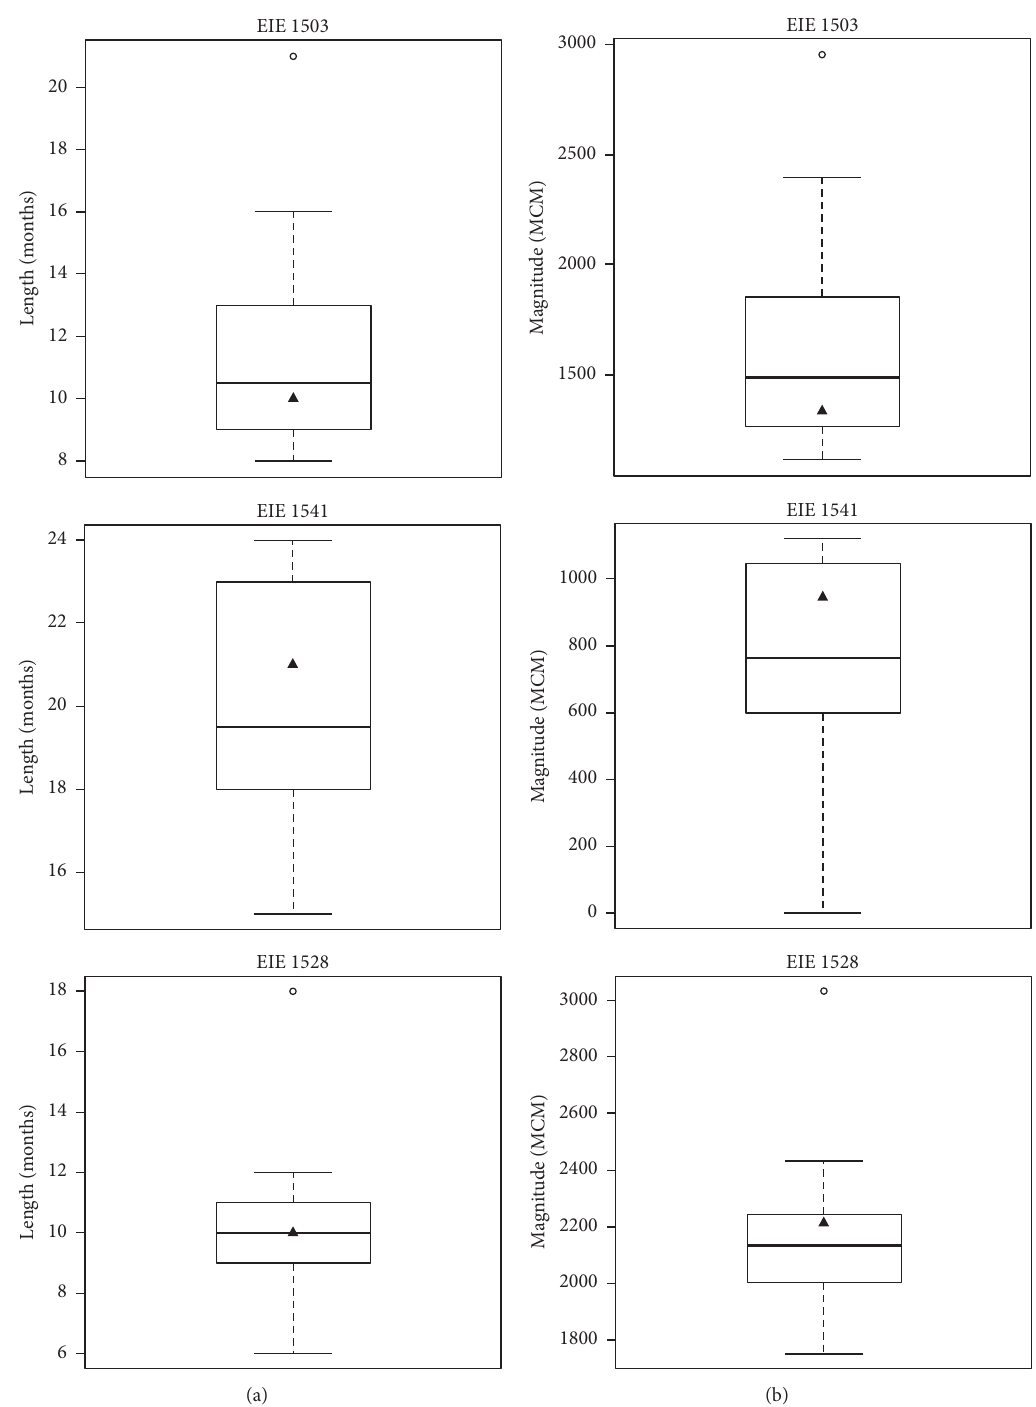
Figure 10: Boxplots of length (a) and magnitudes (b) of maximum monthly droughts from the spatial approach. The triangle denotes the observed